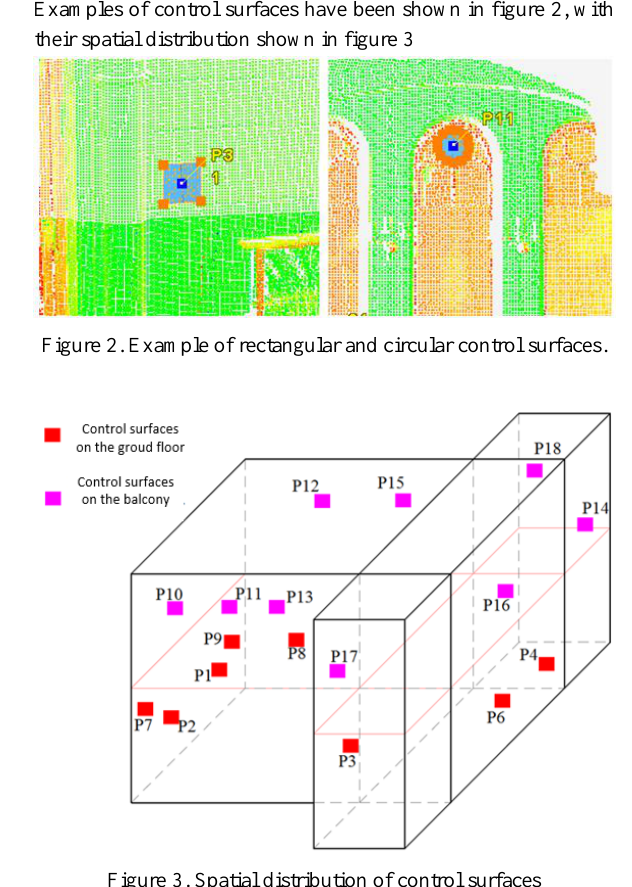
Figure 3. Spatial distribution of control